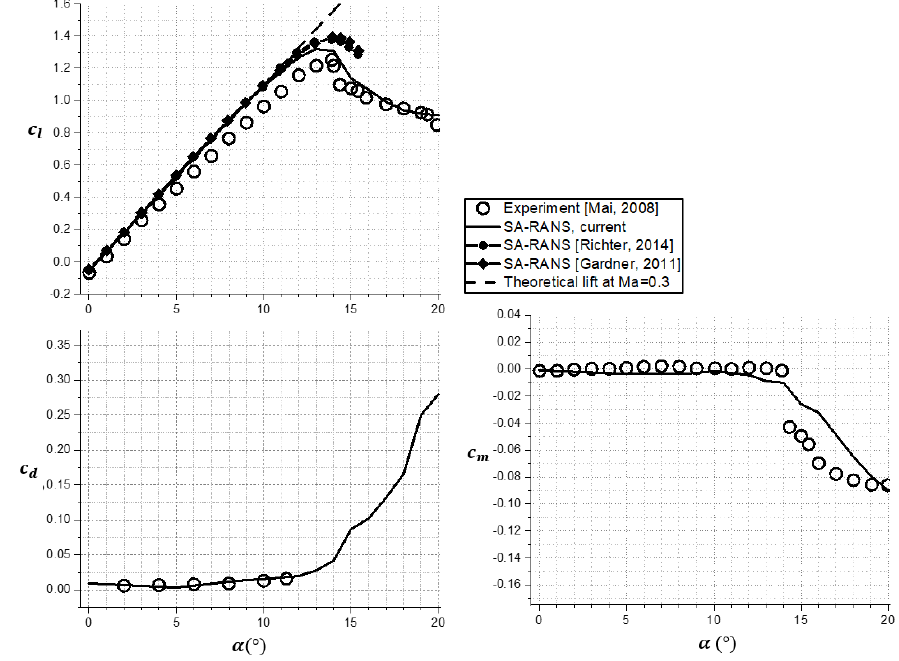
Figure 3. Comparison of the current simulation to the experiment [36] and the SA RANS simulations [19,37] of the clean OA209. Ma = 0.3, Re = 1.15